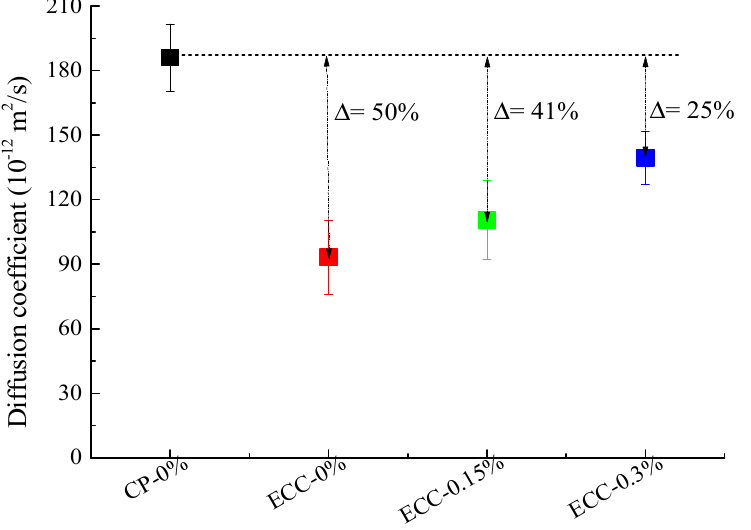
Figure 7. Diffusion coefficients of CP and ECC grouts under various prescribed strains.